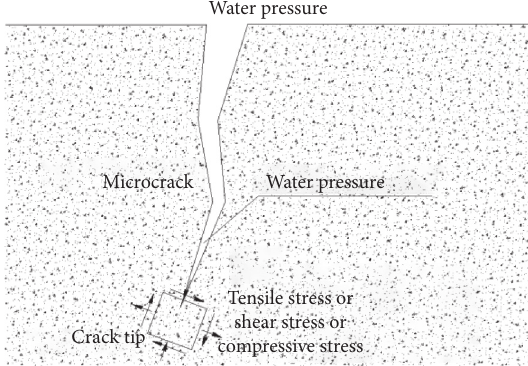
Figure 20: Microcrack propagation as axial stress